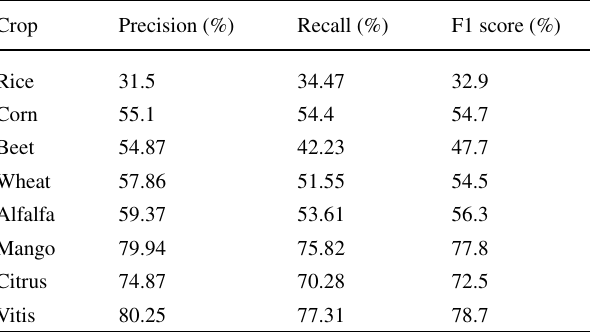
Table 4 Class-wise crop-based insect classification performance of the proposed method